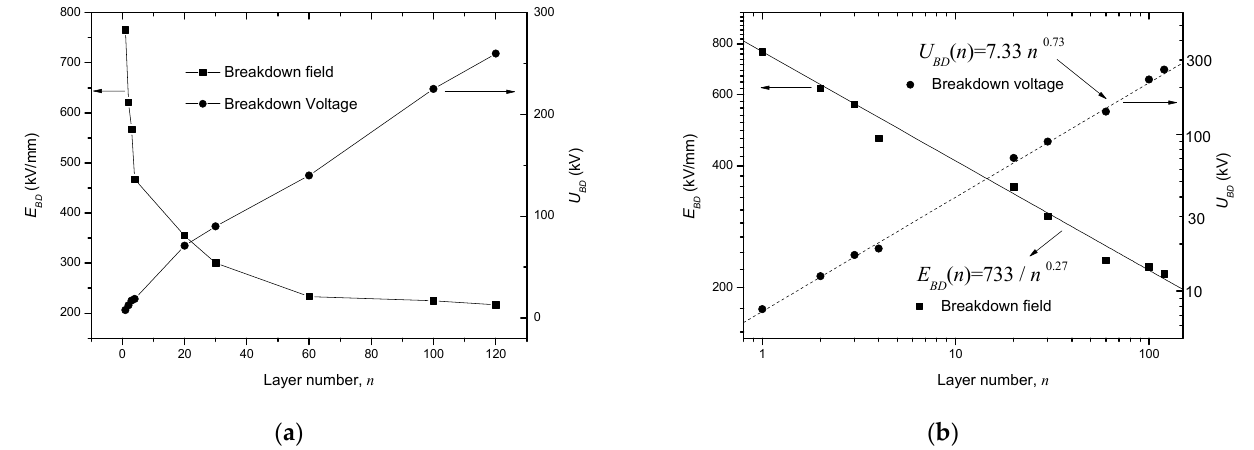
Figure 2. Experimental results of U BD and E BD dependent on d . ( a ) Raw experimental data; ( b ) fitted results in a log-log coordinate system.